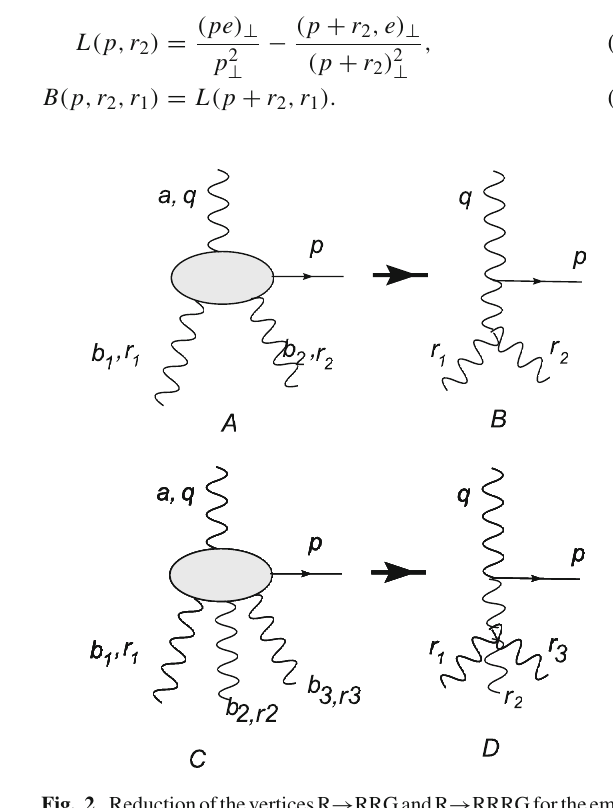
Fig. 2 ReductionoftheverticesR → RRGandR → RRRGfortheemis- sion of a particle (gluon) with a small ”-” component of its